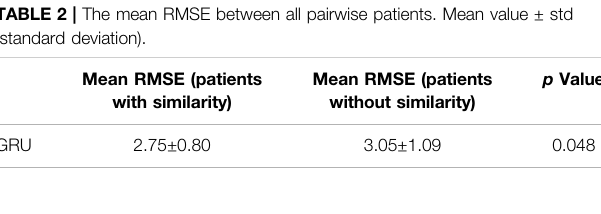
TABLE3| ResultsofTOFRpredictionbasedontransferlearningusingleave-one- out method. Mean value ± std (standard deviation). Mean RMSE (patient